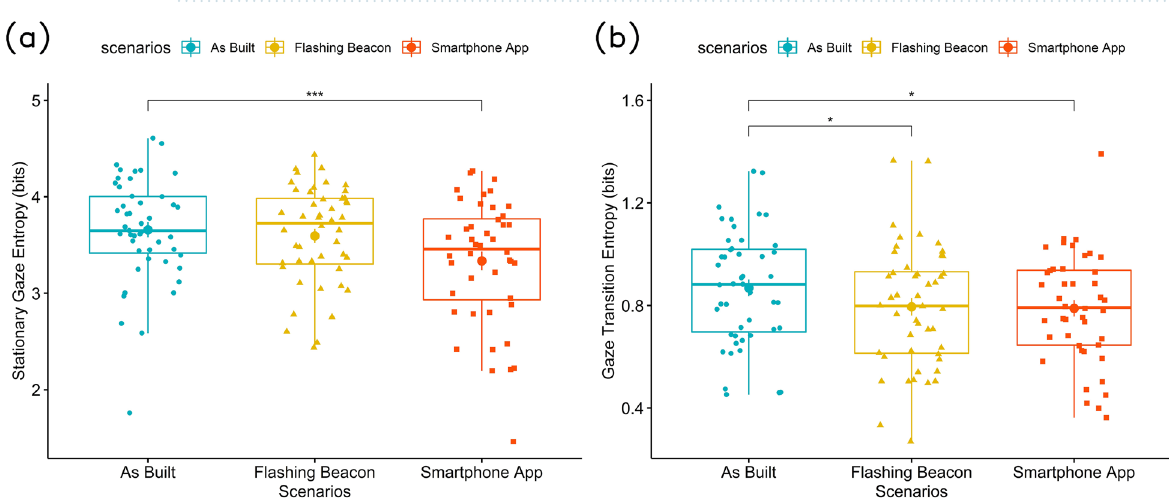
Figure 4. Gaze entropy during crossing of three scenarios, ( a ) stationary gaze entropy, ( b ) gaze transition